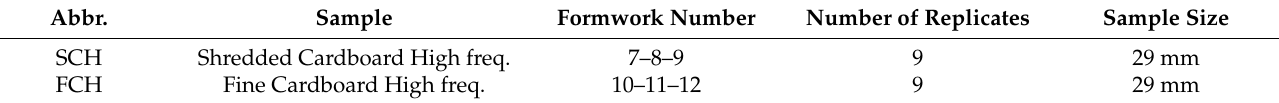
Table 3. Samples Tested for High-Frequency Sound Absorption.